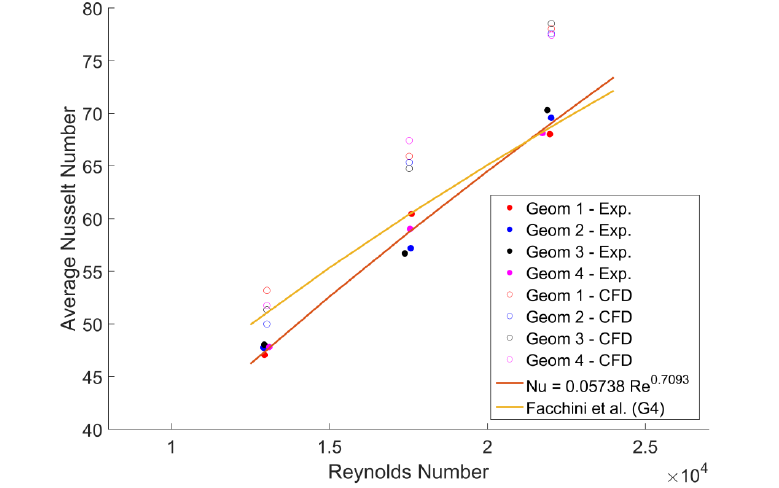
Figure 14. Heat transfer averages—comparison between experiment and CFD